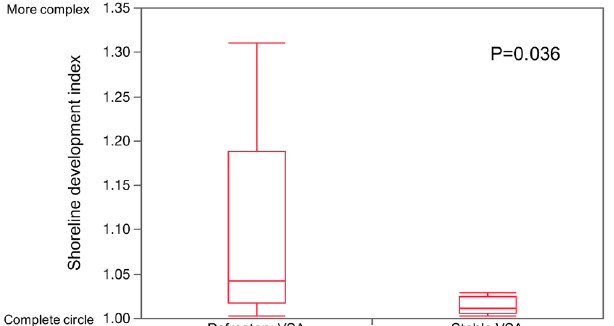
Figure 1. Shoreline development index. A shoreline development index is used in limnology and cartography to assess the complexity of the lake shoreline. The shoreline development index of a complete circle is 1. The shoreline development index of the refractory VSA group is larger than that of the stable VSA group (refractory VSA 1.042 [1.017–1.188] vs stable VSA 1.003 [1.006–1.025], p = 0.036).